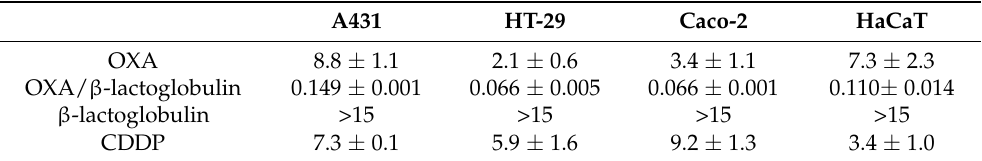
Figure 4. Effect of OXA/ β -lactoglobulin and OXA on the survival of eukaryotic cells. Immortalized human keratinocytes (HaCaT, green circle), human epidermoid carcinoma (A431, red squares), human colorectal adenocarcinoma (Caco-2, purple triangles and HT-29, blue asterisks) were incubated with increasing amounts of OXA ( A ) or OXA/ β -lactoglobulin ( B ) for 72 h. Cell viability was assessed using a 3-(4,5-dimethylthiazol-2-yl)-2,5-diphenyltetrazolium bromide (MTT) assay and expressed as described in the Materials and Methods section. Values are given as means ± SD ( n > 3). Table 1. IC 50 values for OXA, β -lactoglobulin, and the adduct OXA/ β -lactoglobulin. Values are reported as metal concentration ( µ M). Values are given as means ± SD ( n > 3). CDDP is reported as reference.